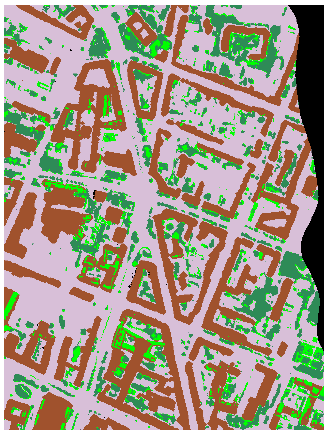
Figure 3. Training Data for SVM Classification